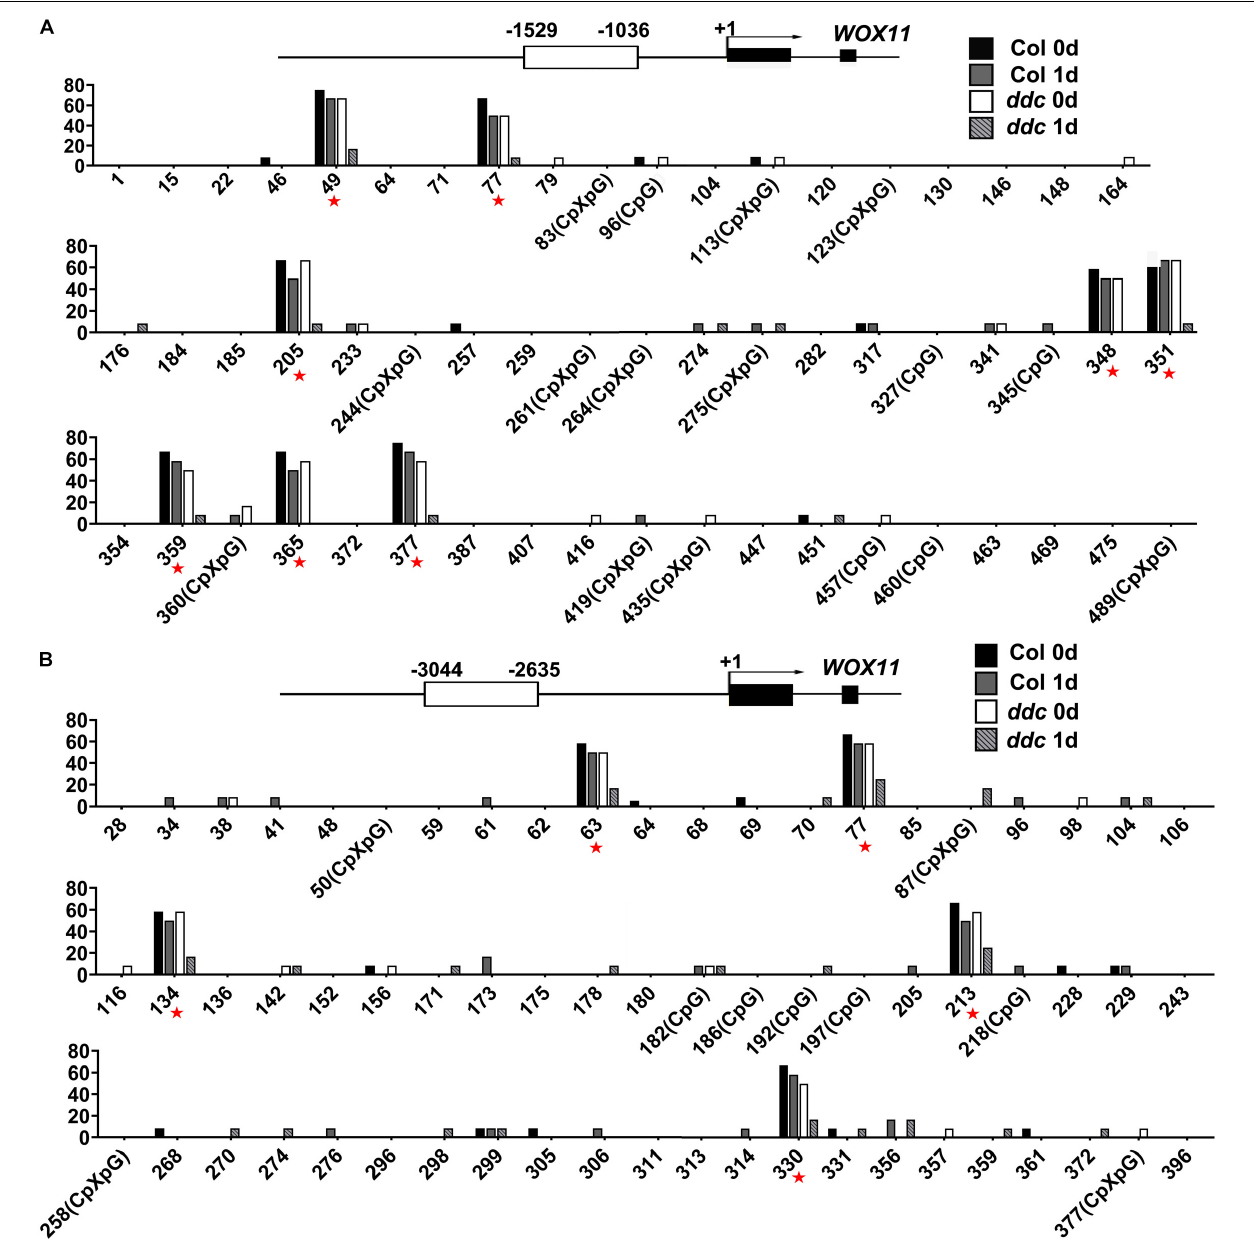
FIGURE 7 | Analysis of methylation level in the promoter region of WOX11 via bisulfite sequencing. Levels of cytosine methylation in genomic fragments 1,036–1,529 bp (A) and 2,635–3,044 bp (B) upstream of the coding sequence were detected. Root explants incubated under NAA-treatment were used for analysis. Red